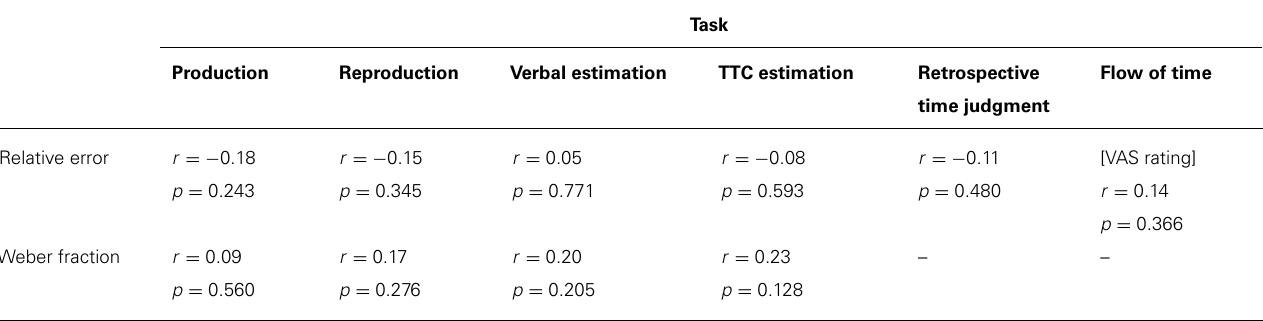
Table 1 | Correlations between the relative errors orWeber fractions and the total BDI score, with two-tailed p